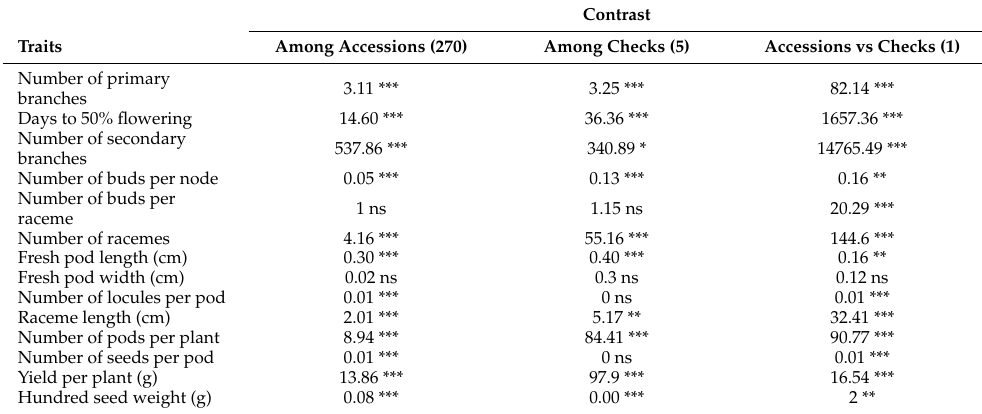
Table 3. Analysis of the differences and interactions among accessions, among control and between accessions and checks across the two cropping